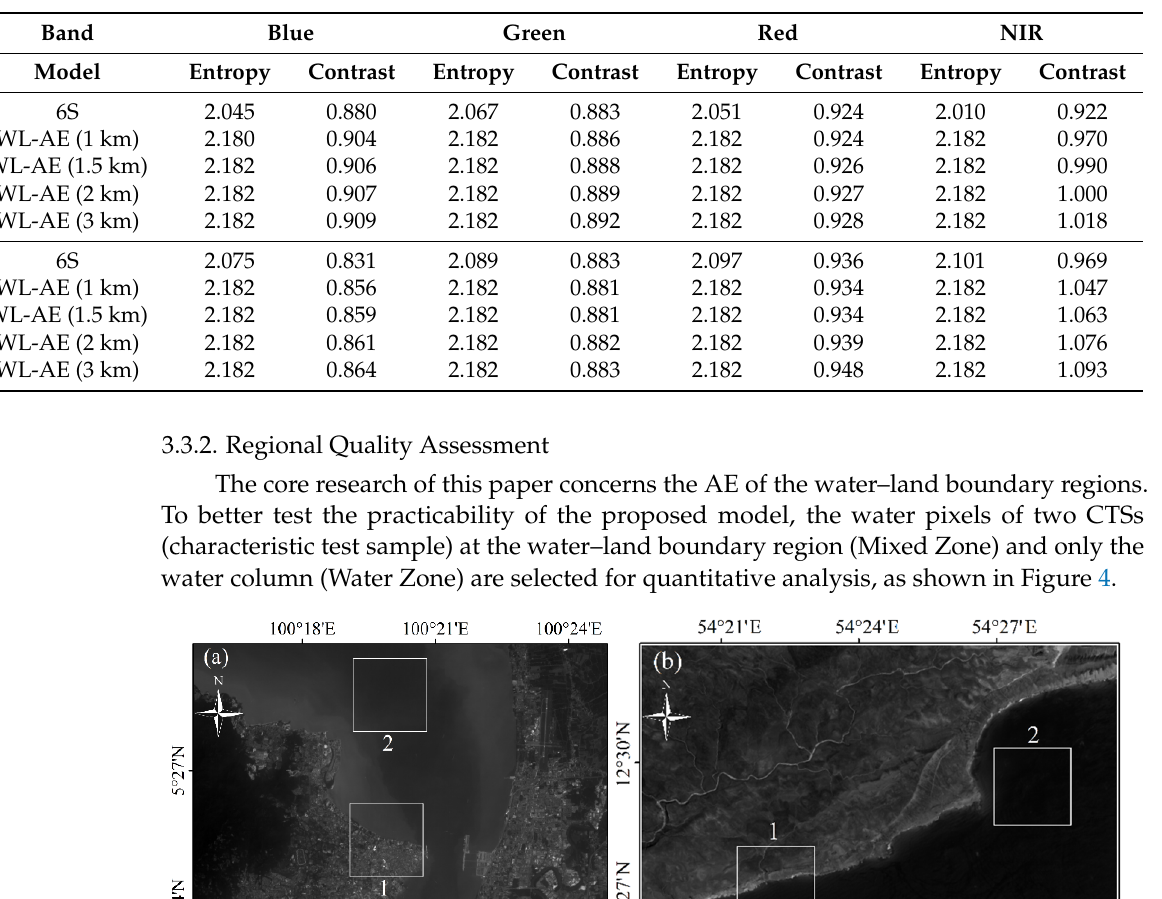
Table 2. Evaluation of the AC Results.